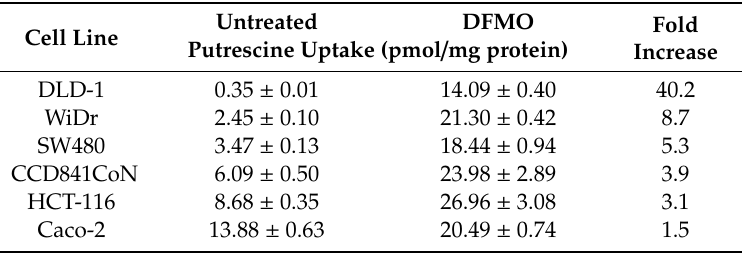
Table 2. The e ff ect of inhibition of PA biosynthesis on putrescine uptake in a range of colorectal cancer and normal